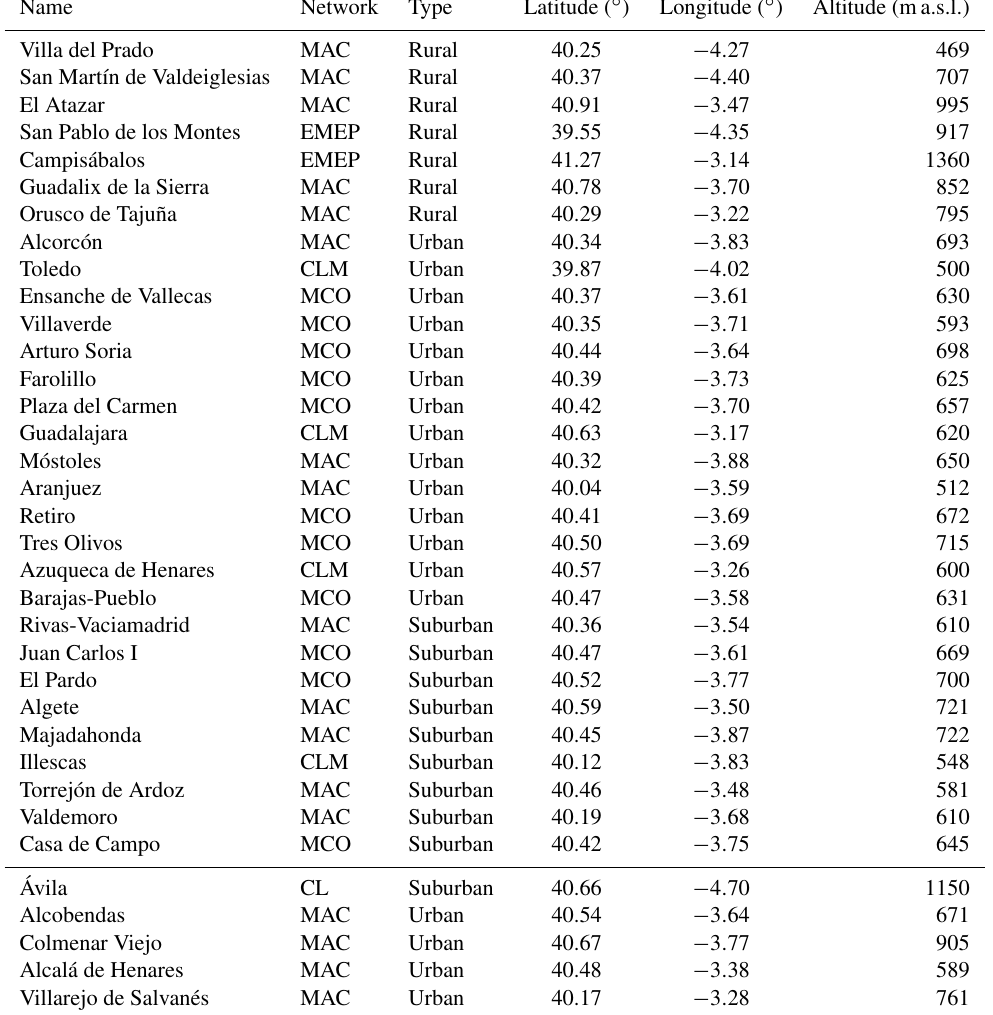
Table 2. Details of the air-quality monitoring stations selected for this study. With the exception of the last five, which are classified as traffic sites, all the stations included in this table are located in background locations. Network codes: MCO, Madrid City Council; CL, Castilla y León region; CLM, Castilla–La Mancha region; MAC, Madrid region; and EMEP (European Monitoring and Evaluation